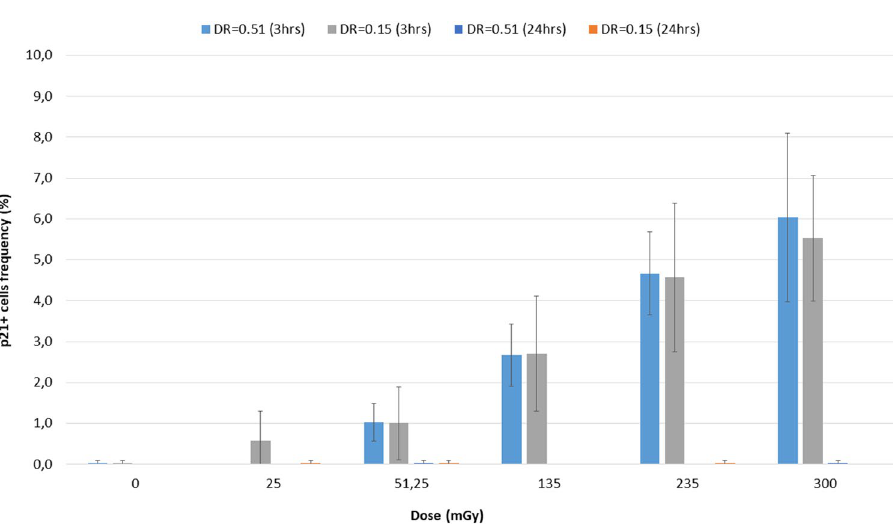
Figure 12. Frequencies of p21-positive cells. After 3 h, all irradiated samples showed frequencies of p21- positive cells higher than the unirradiated control. After 24 h, the level of p21-positive cells was the same as in unirradiated samples. Dose rate (DR) is expressed in